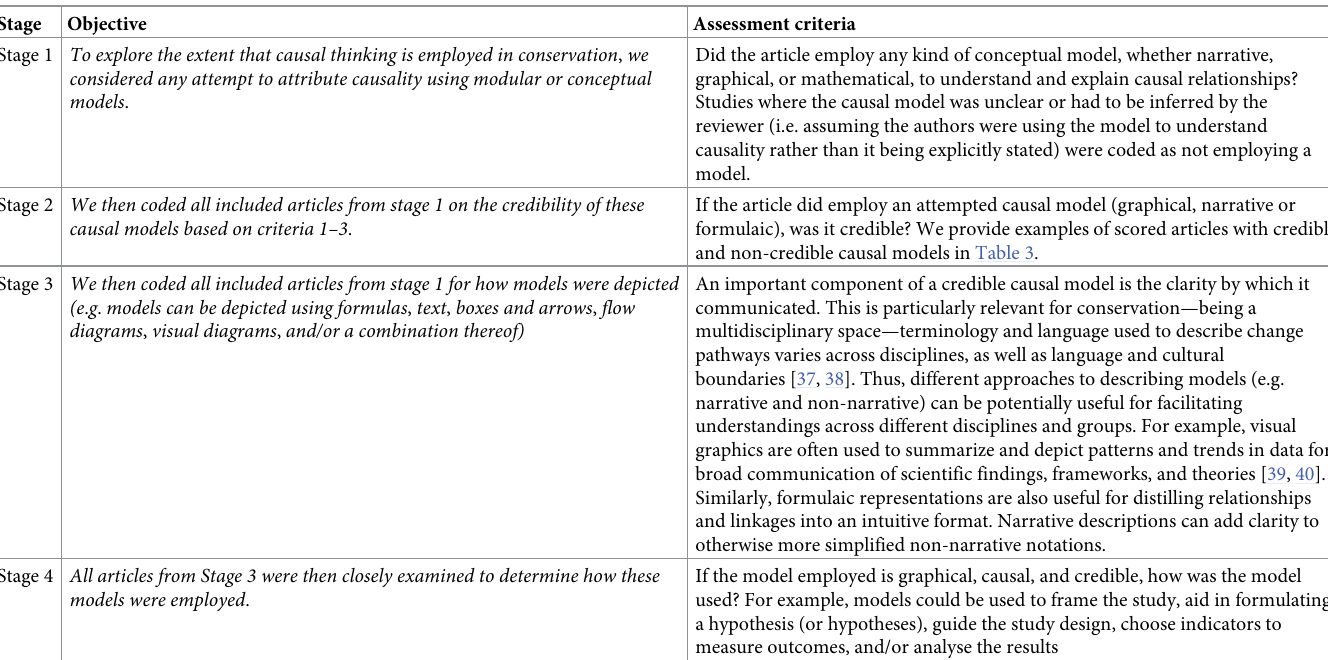
Table 2. Summary of screening and coding strategy. Stage Objective Assessment criteria